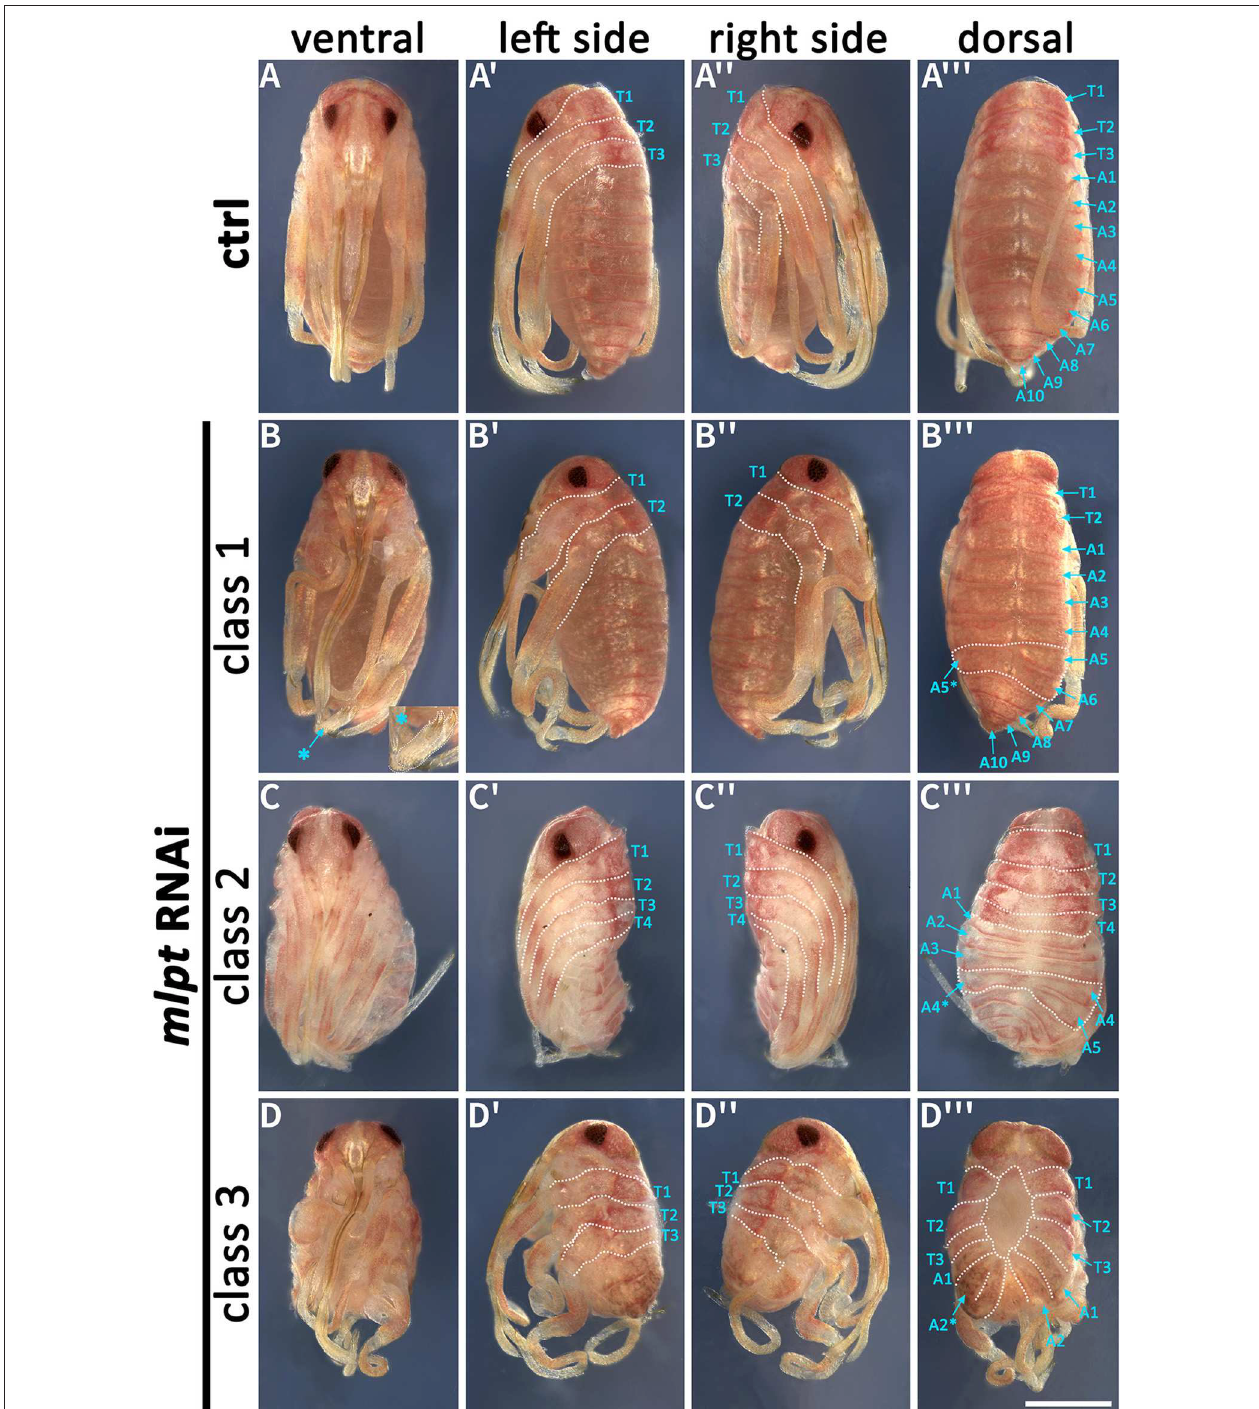
FIGURE 5 | Phenotypic classes of mlpt RNAi late embryos. mlpt knockdown embryos were classified in three phenotypical classes when compared to the control (A-A ′′′ ) . (B–B ′′′ ) Class 1—Embryos displaying only two thoracic segments and distal leg duplications (asterisk) (B–D) . Abdominal segmentation appears normal with the exception of some asymmetrical segmental divisions on left and right sides (asterisk) (20 out of 45 embryos). (C–C ′′′ ) Class 2—Embryos displaying four thoracic segments and irregular abdominal segmentation (15 out of 45 embryos). (D–D ′′′ ) Class 3—Shorter embryos only displaying thoracic segments and fewer abdominal segments then controls (10 out of 45